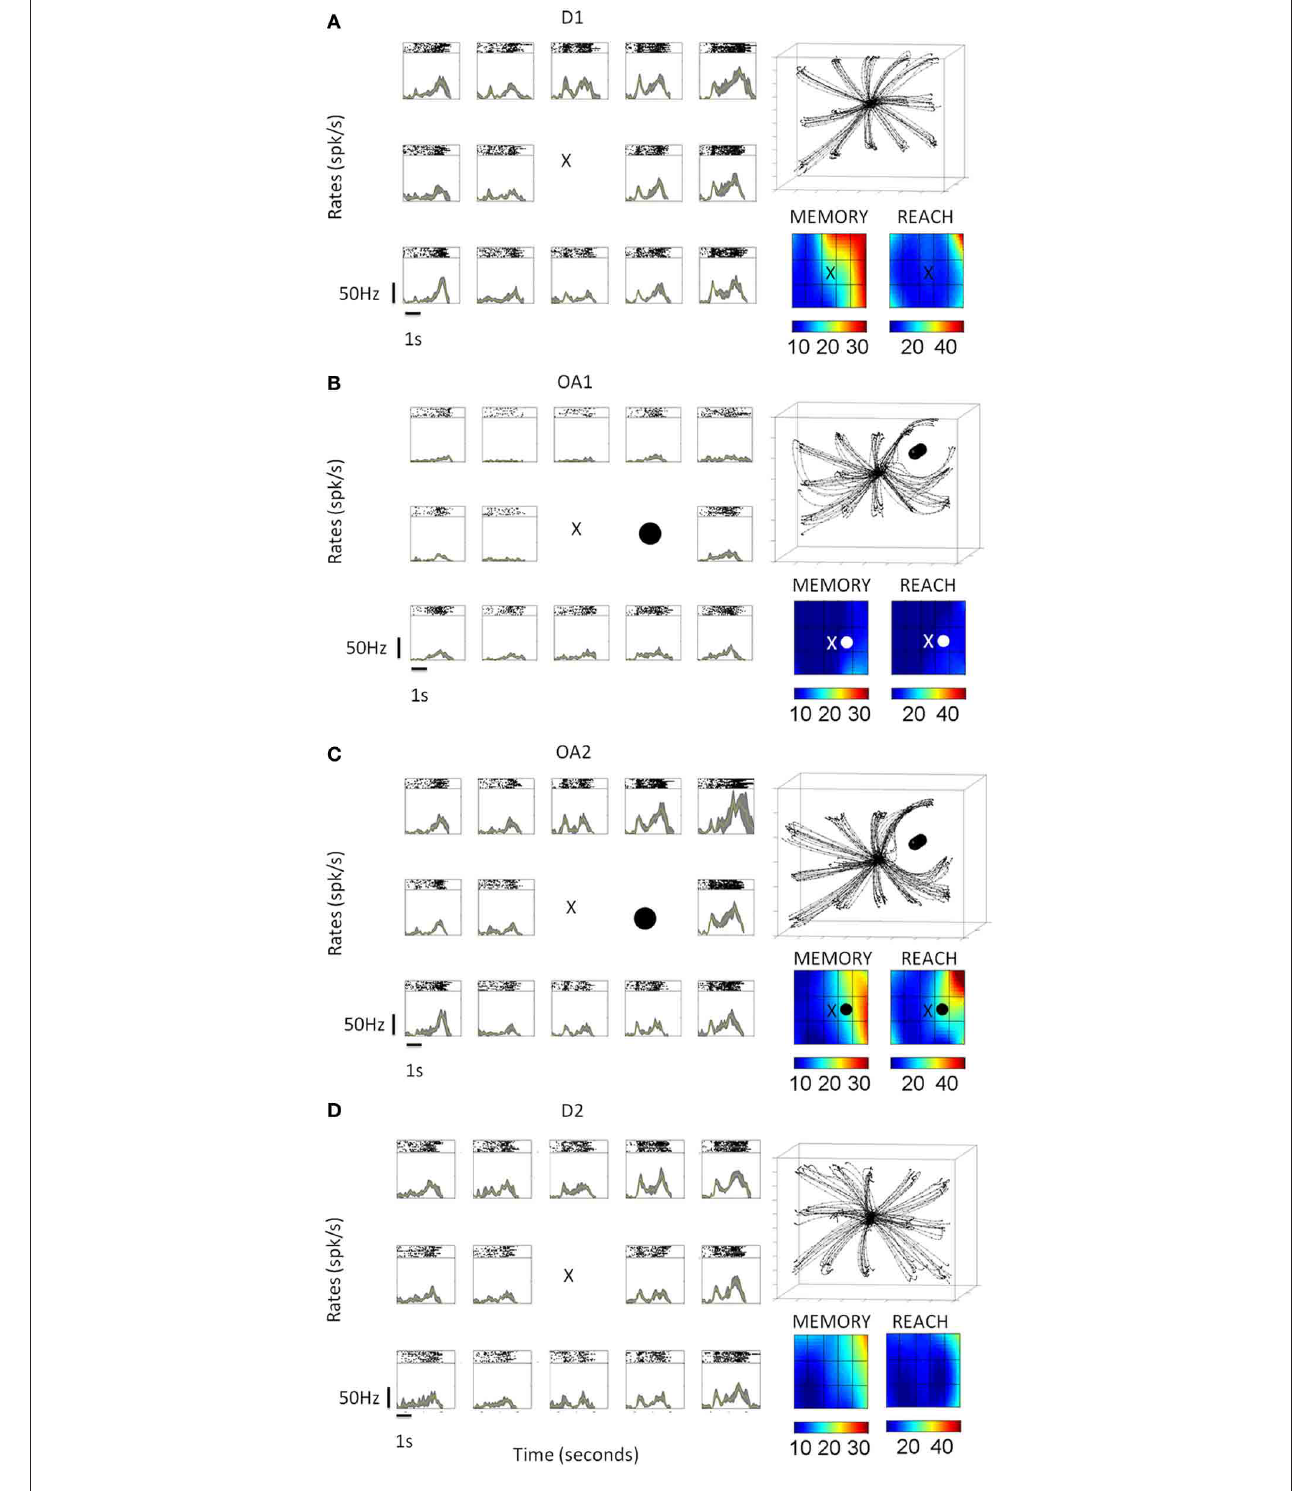
FIGURE 3 | Neural activity from a single example cell under different conditions (D1, OA1, OA2, and D1, shown top–down as time progress). The concurrently recorded hand trajectories are also shown for each block. (A) D1 activity across all epochs (baseline, cue, memory, and reach) for 14 board locations. Color maps built by interpolating the mean firing rates